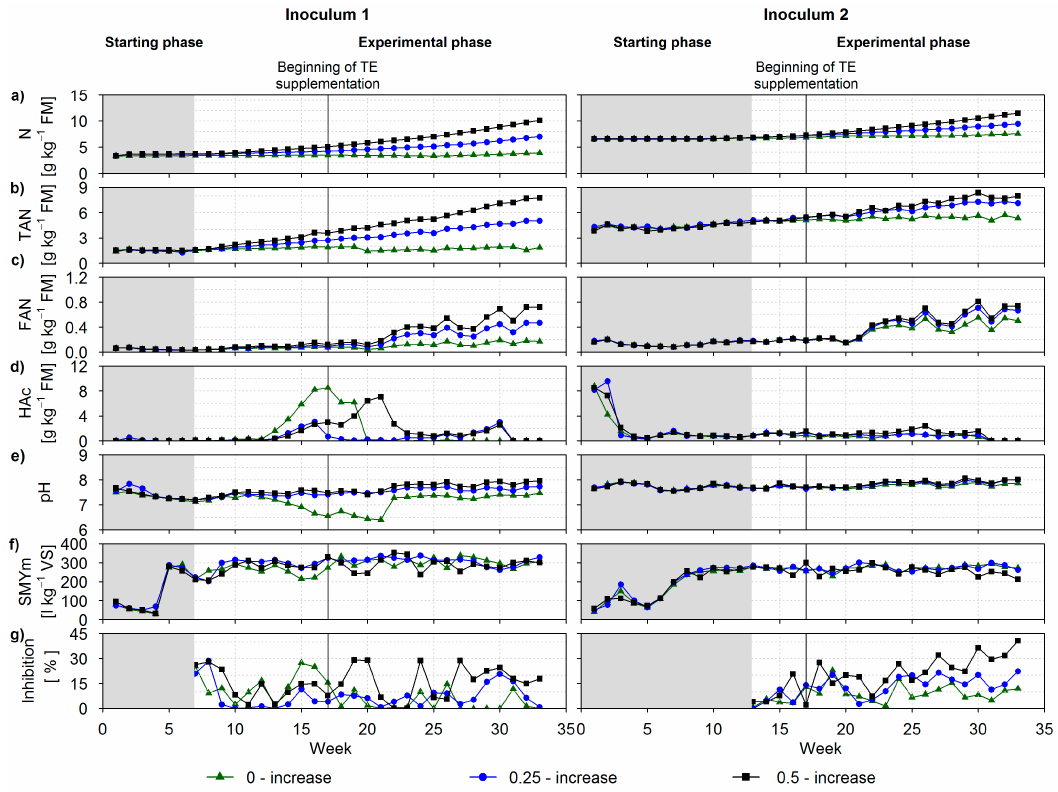
Figure 2. Measured values of the following parameters in the continuously stirred tank reactors (CSTR) under di ff erent N-increase rates in feeding regimes: ( a ) total nitrogen (N); ( b ) total ammonia nitrogen (TAN); ( c ) free ammonia nitrogen (FAN); ( d ) acetic acid (HAc); ( e ) pH; ( f ) the measured values of specific methane yield ( SMY m ); ( g ) inhibition in specific methane yield (Inhibition). The results are given separately for inoculum #1 and inoculum #2. Di ff erent line colours along with di ff erent marks in the graphs and in the legend correspond to the N-increase rates “0-increase”, “0.25-increase” and “0.5-increase” in the feeding regimes. Grey and white backgrounds in the graphs are related to the starting phase and the experimental phase, respectively. The vertical line in the graphs corresponds to the beginning of regular weekly trace elements (TE) supplementation.